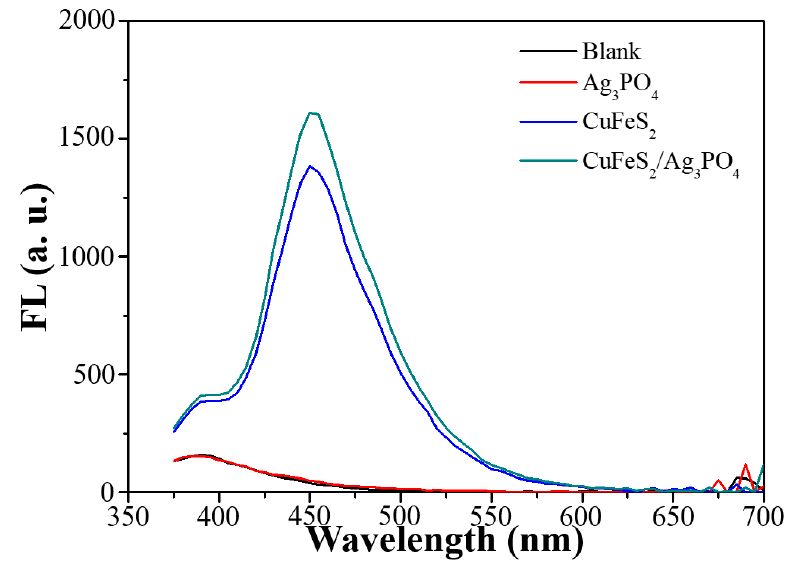
Figure 15. FL spectra of the different samples in the coumarin solution measured at λ ex = 370 nm (each sample was illuminated for 10 min under visible light). Ag 3 PO 4 (red), CuFeS 2 (blue), and CuFeS 2 /Ag 3 PO 4 composites (olive).